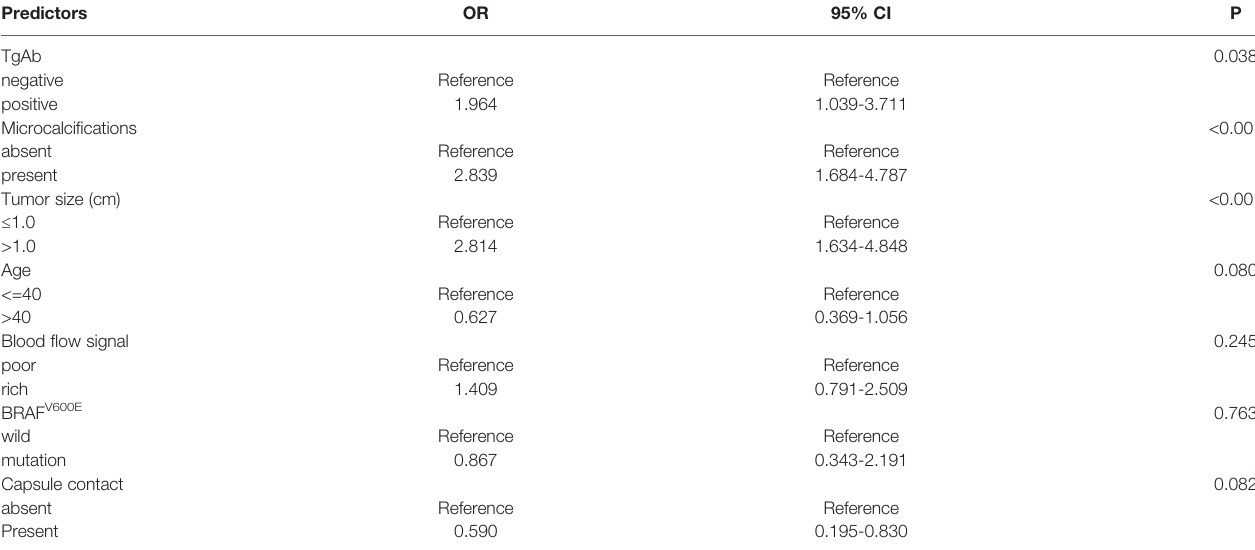
TABLE 2 | Multivariate logistic regression analysis of the relationship between predictors of PTC (signi fi cant by univariate analysis) and central CLNM. Predictors